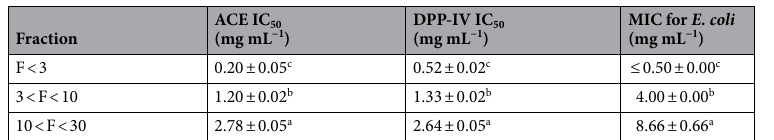
Table 2. Biological activities of gelatin hydrolysate fractions obtained by ultrafiltration separation. Data are shown as mean ± standard error of three replicates. Different superscript letters in the same column represent significant differences ( P < 0.05). ACE, angiotensin-converting enzyme; DPP-IV, dipeptidyl peptidase IV; IC 50 , half maximal inhibitory concentration; MIC, minimum inhibitory